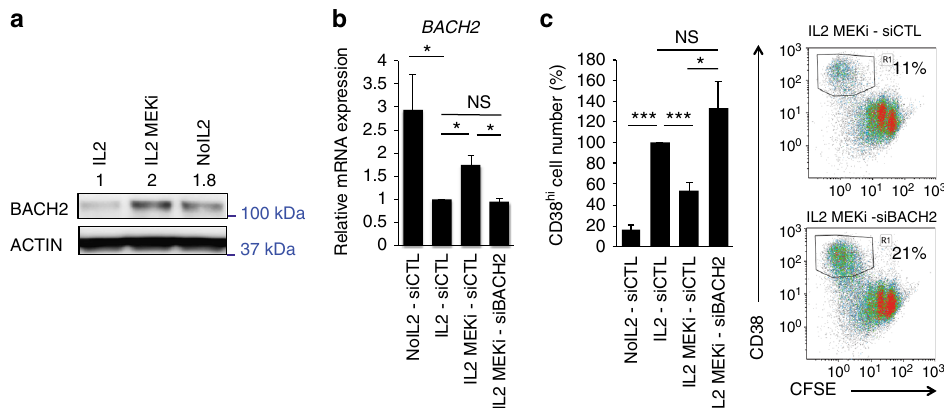
Fig. 4 BACH2 mediates the effect of IL-2/ERK signalling on plasma cell differentiation. a BACH2 protein levels in D4-activated B cells primed in the absence (No IL2) or in the presence of IL-2 (IL2) and MEK inhibitor (MEKi) added on D2. β -ACTIN was used as loading control. Values are the average fold changes in the expression levels of BACH2 for three experiments. b Gene expression levels of BACH2 in D4-activated naive B cells that were electroporated on D2 with siRNA and stimulated with or without IL-2 (IL2, No IL2, respectively) and treated with MEKi. Expression levels analysed by QRT-PCR were normalised to expression level in the IL-2 primed control cells from three independent experiments. c Plasma cell differentiation was monitored by fl ow cytometry at D7. CD38 hi CFSE lo cells were quanti fi ed for three independent experiments. Results were normalised to the IL2- siCTL condition arbitrary fi xed to 100 for all the experiments. Values shown in b and c are means ± s.e.m., * p < 0.05, ** p < 0.01, *** p < 0.005, NS: No signi fi cant differences,